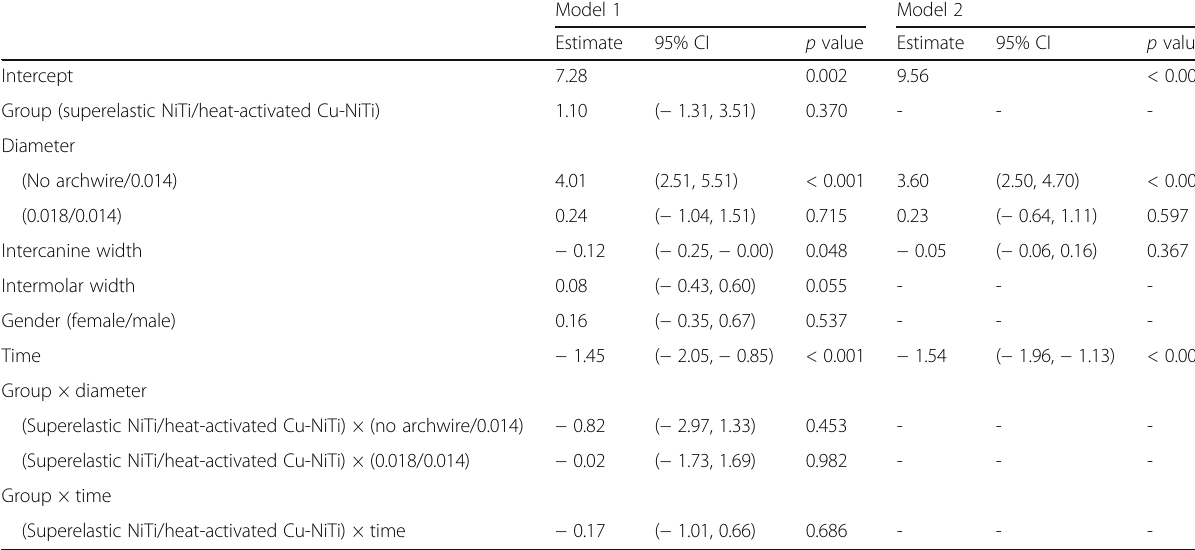
Table 5 Confounding variables for irregularity reduction, estimate, 95% confidence intervals, and estimate values for